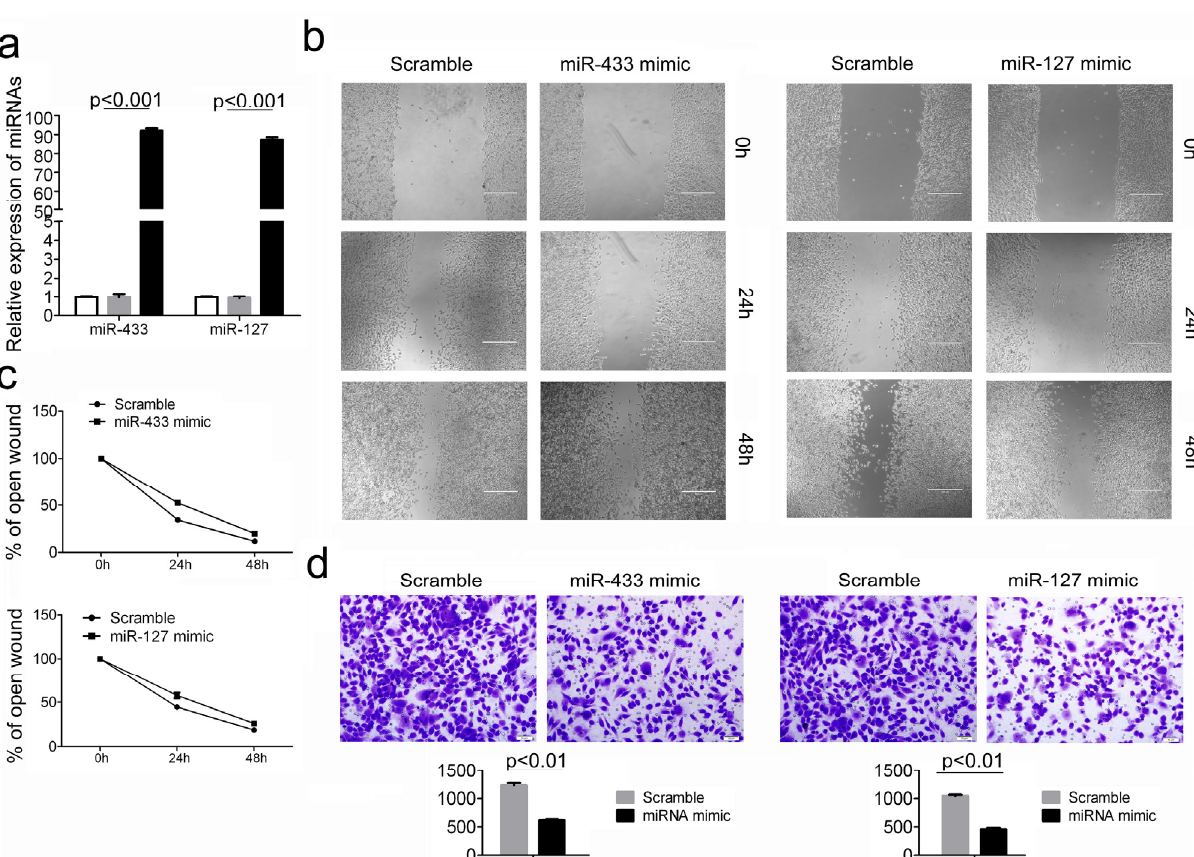
Figure 3. The influence of miR-433 and miR-127 on GC cell migration and invasion. ( a ) MiR-433 and miR-127 level were detected in HGC-27 cells after treatment with miRNA mimic or Scramble by uantitative RT-PCR; ( b , c ) Wound healing assays of HGC-27 cells after treatment with miRNA mimic or Scramble, The relative ratio of wound closure per field was shown in (c); ( d ) Transwell analysis of HGC-27 cells after treatment with miRNA mimic or Scramble, The relative ratio of invasive cells per field was shown